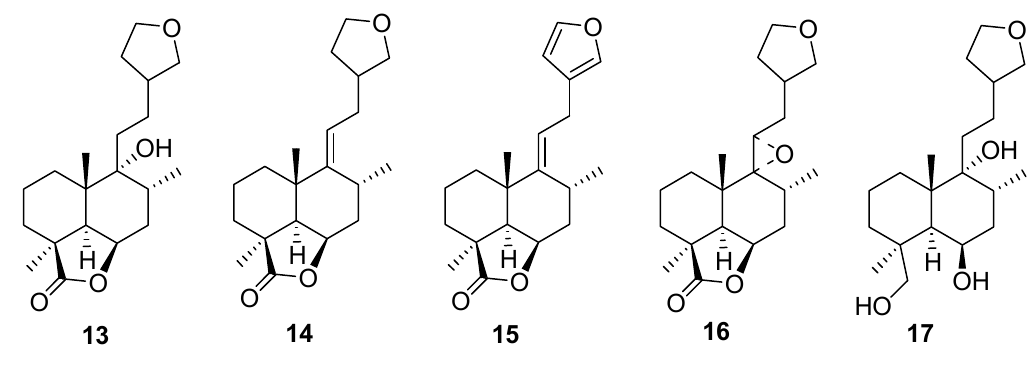
Figure 4. Different derivatives of marrubiin (compounds 13 – 17